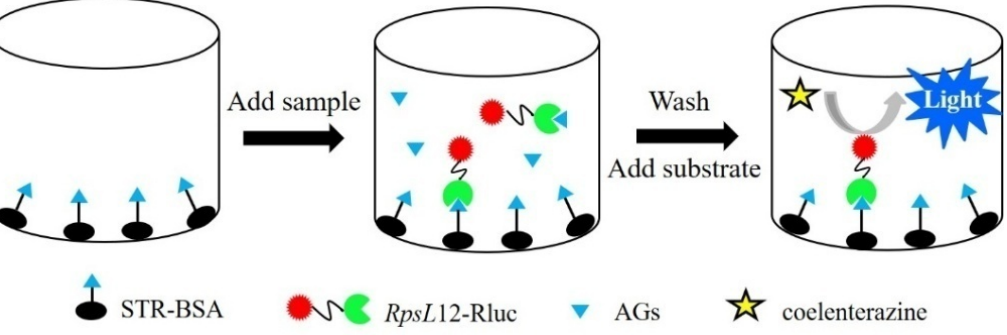
Figure 2. Schematic representation of the RpsL12–Rluc-fusion-protein-based bioluminescent method.